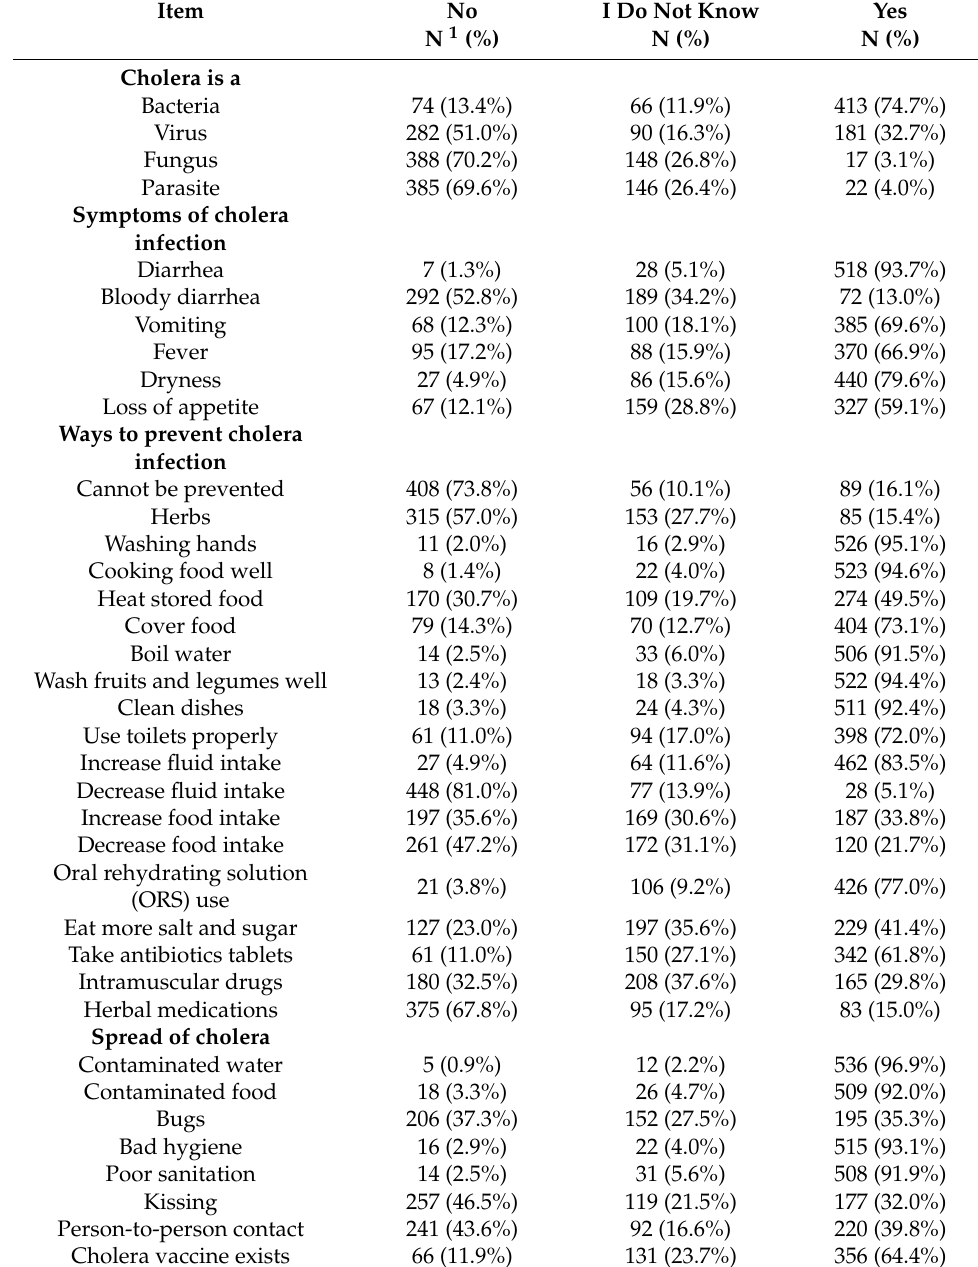
Table 2. Description of the cholera knowledge